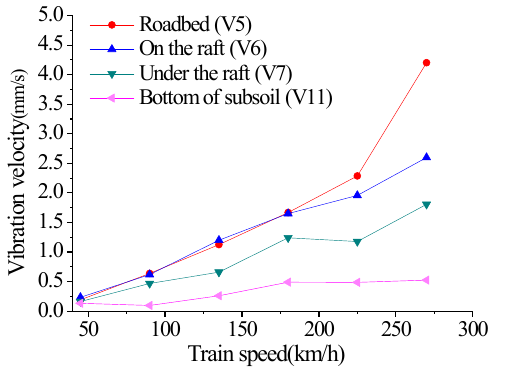
Figure 12. Relationship between the vibration velocity and train speed at the locations V5, V6, V7, and V11.